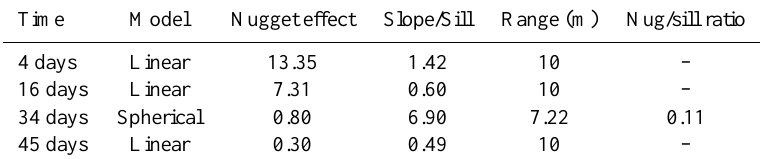
Table 3. Best-fitted omnidirectional variogram models of ash thickness and corresponding parameters.